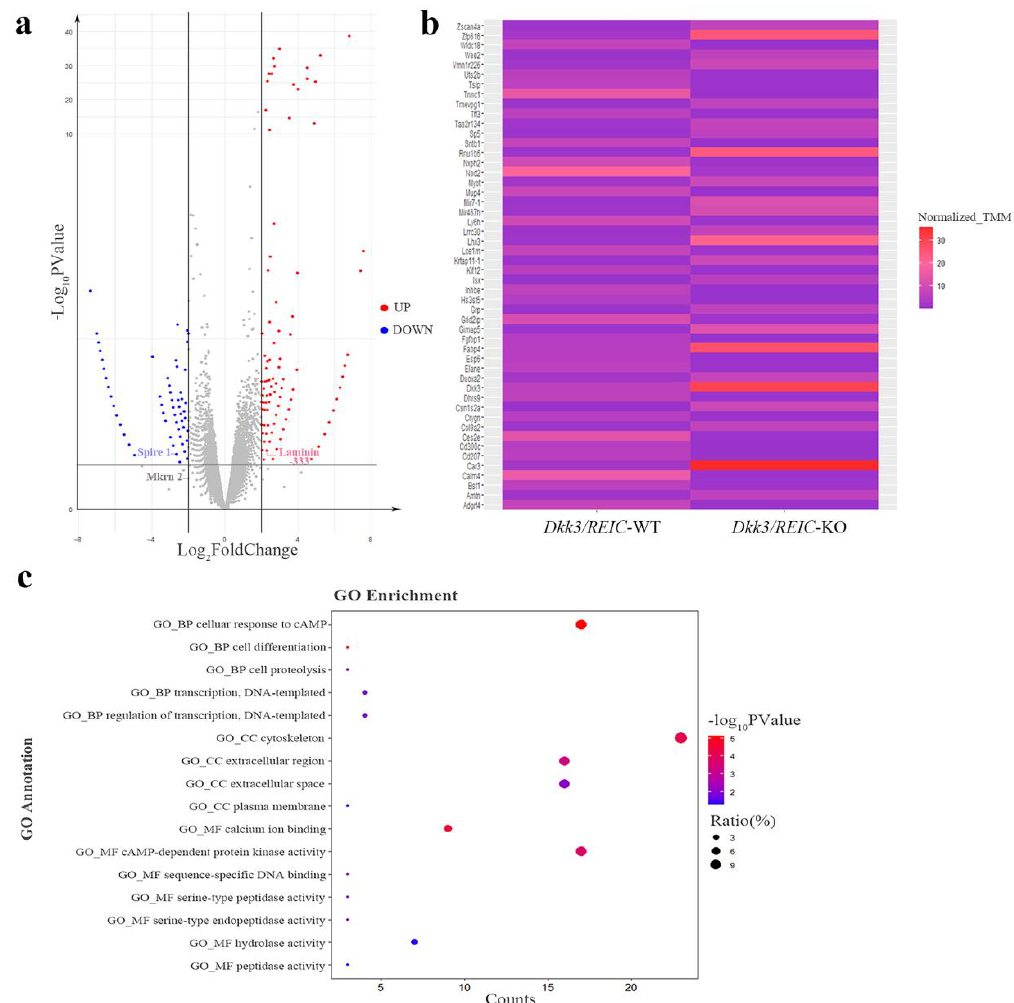
Figure 5. Differentially expressed genes and enrichment results of Dkk3/REIC -WT and Dkk3/REIC -KO mice. ( a ) Volcano plot of differentially expressed genes (DEGs). Genes with significant difference (FDR < 0.05 and fold change ≥ 2) are marked in colors. Red and blue, respectively, indicate the up-regulated and down-regulated genes in Dkk3/REIC -KO mice. DEGs of Laminin-333 , Spire 1 and Mkrn 2 are marked by labels. ( b ) The relative expressions of the top 50 DEGs among Dkk3/REIC -WT and Dkk3/REIC -KO mice testes. ( c ) The top 200 DEGs analyzed by Gene Ontology (GO) enrichment.